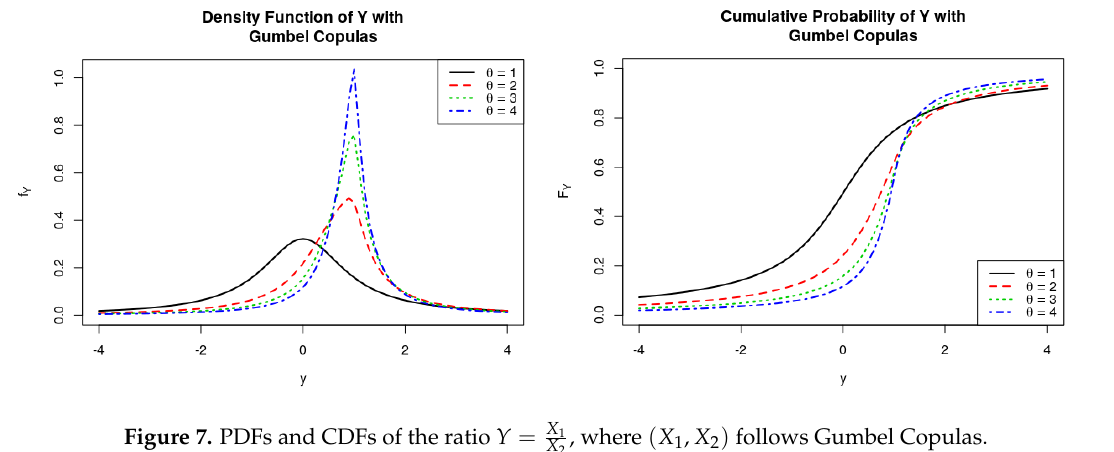
Figure 7. PDFs and CDFs of the ratio Y = X 1